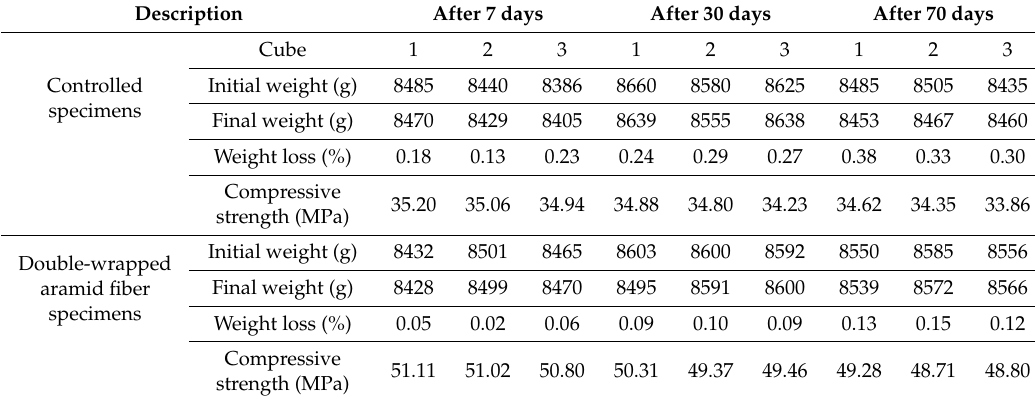
Figure 3. Weight loss in the acid resistance test.